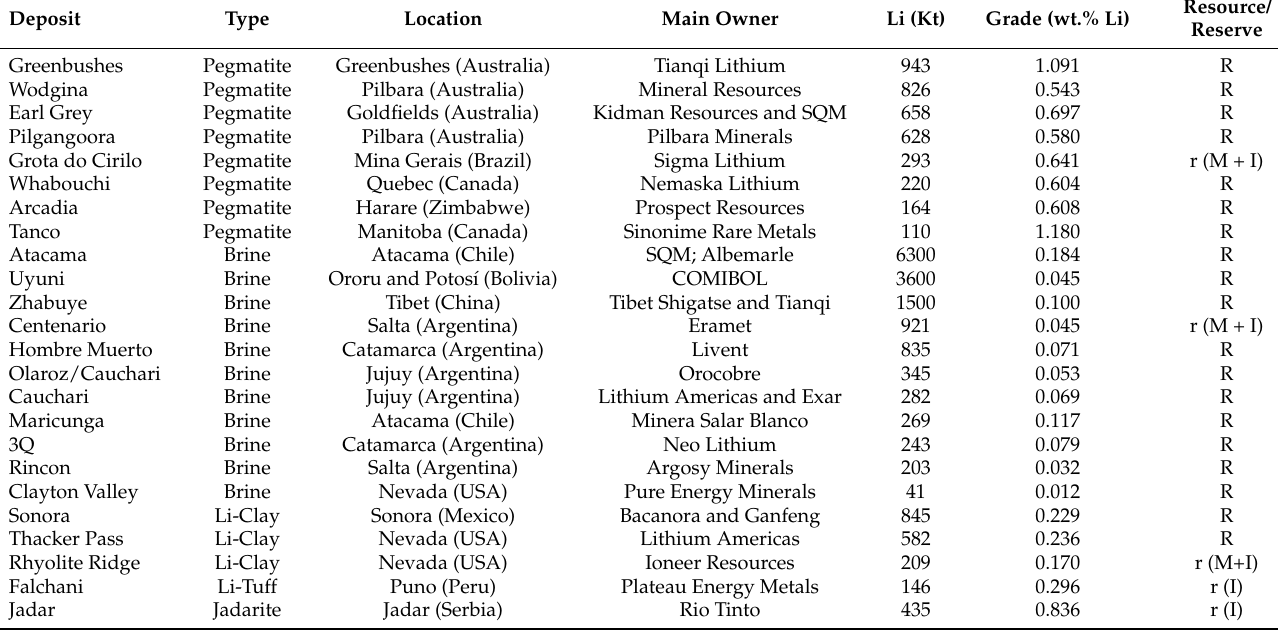
Table 4. World-class lithium deposits for pegmatites, continental brines, tuffs, jadarite, and lithium clays